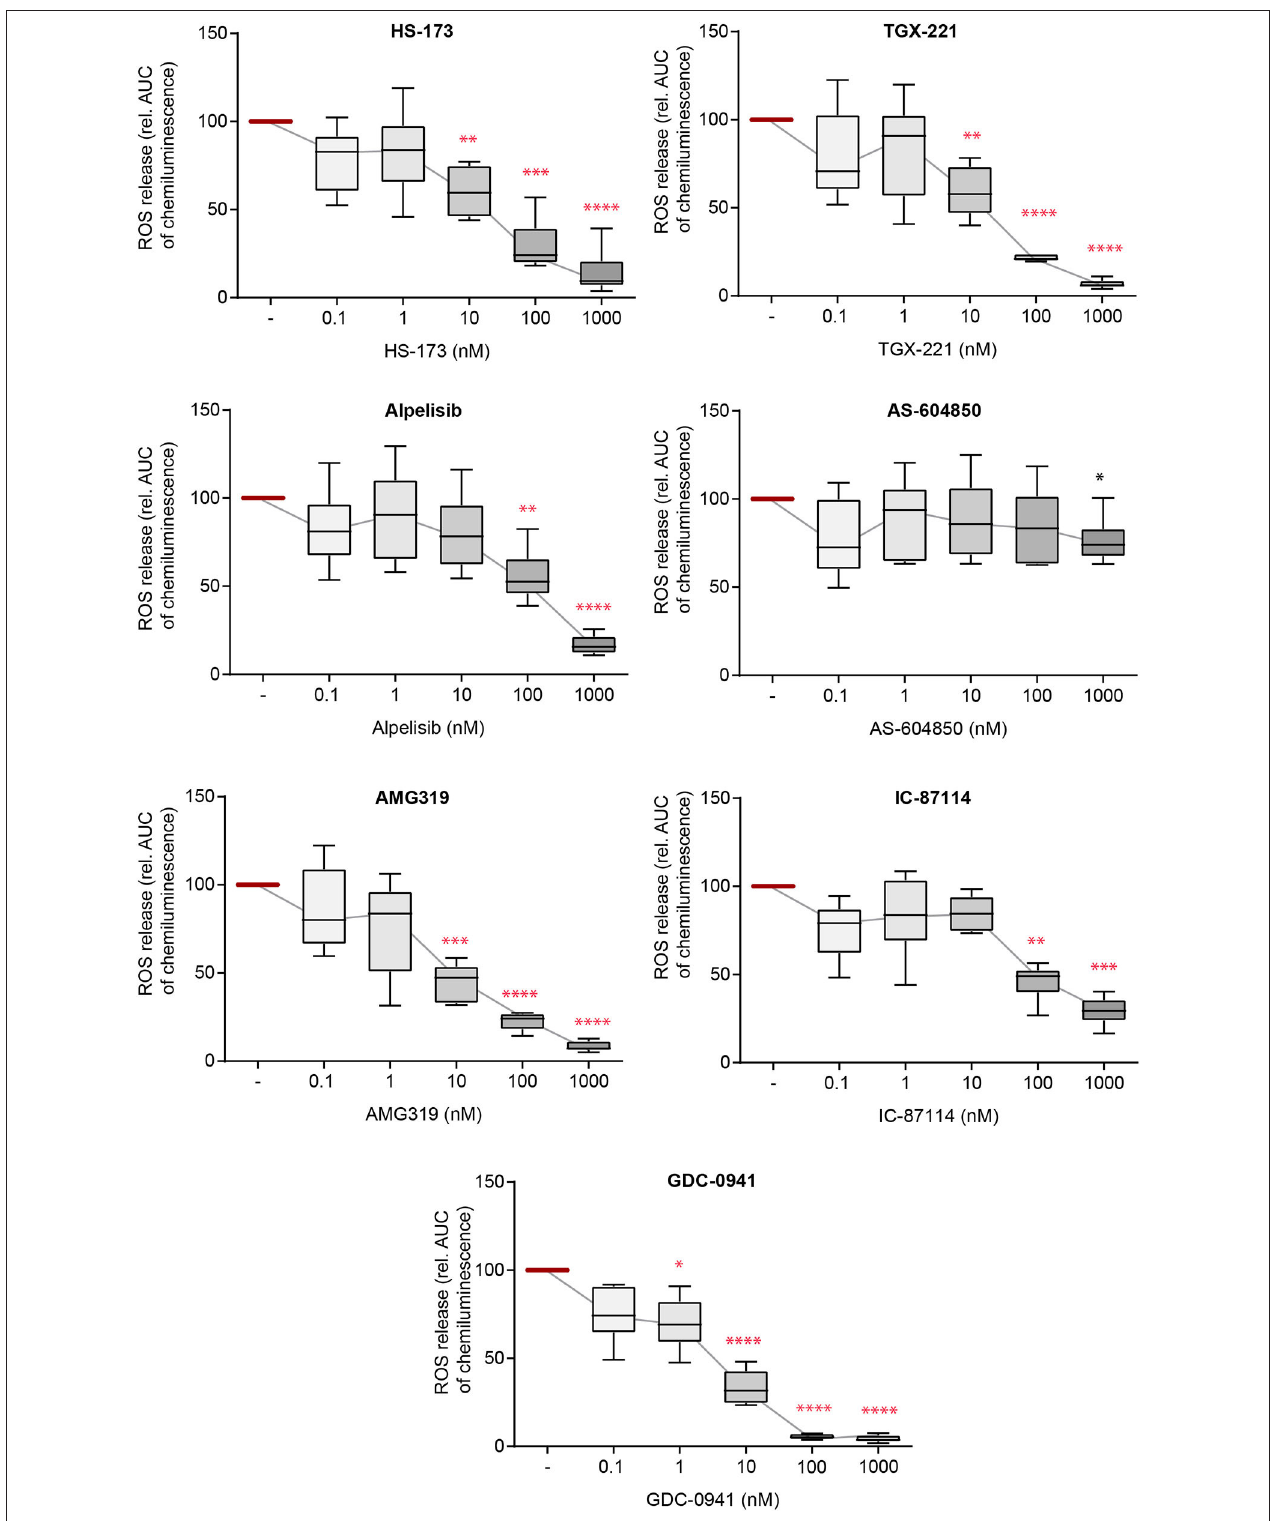
FIGURE 3 | Immune complex (IC)-induced reactive oxygen species (ROS) release from PMNs depends on different PI3K isoforms. Human PMNs were activated with immobilized ICs in the presence of either one of the PI3K isoform-selective inhibitors. Release of ROS was tracked for 2h and the area under curve (AUC) was calculated. Data were normalized to positive control (IC-stimulated PMNs with solvent). Data are shown as Tukey’s box-and-whisker plots. n = 6. ANOVA on ranks (Kruskal-Wallis) was applied followed by a Bonferroni t -test for multiple comparisons. Data were normalized to stimulated cells. * p < 0.05, ** p < 0.01, *** p < 0.001, **** p <